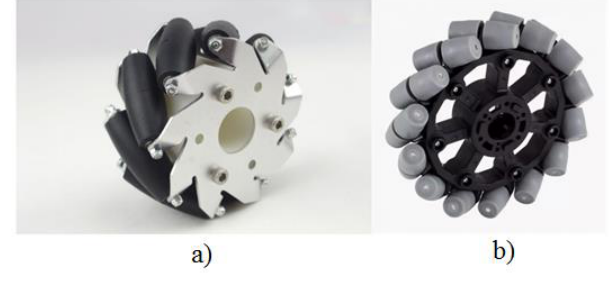
Fig. 1. Mecanum wheel design